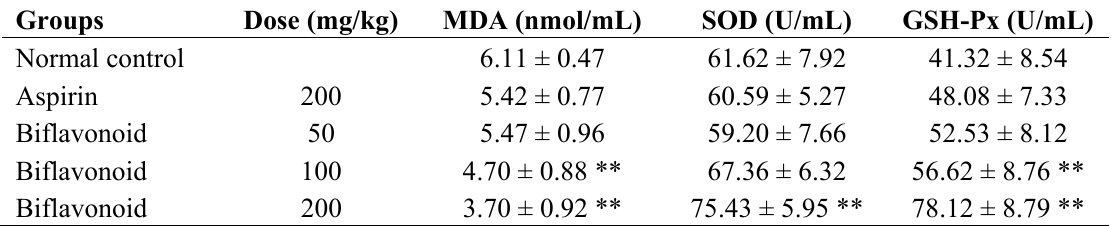
Table 5. Effect of the biflavonoid on malonaldehyde (MDA), superoxidase dismutase (SOD) and Glutathione peroxidase (GSH-Px) activities in blood of rats.